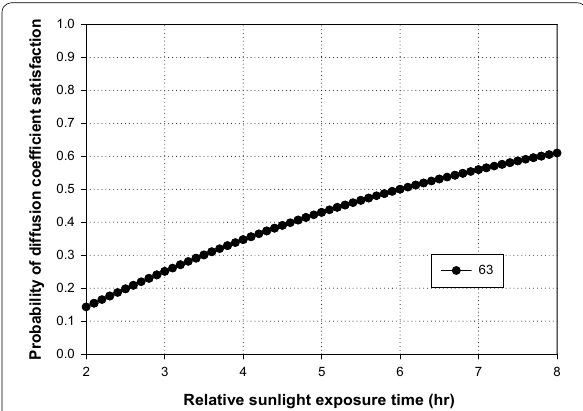
Fig. 12 Satisfaction Curve of sunlight exposure time parameter for chloride diffusion coefficient rate